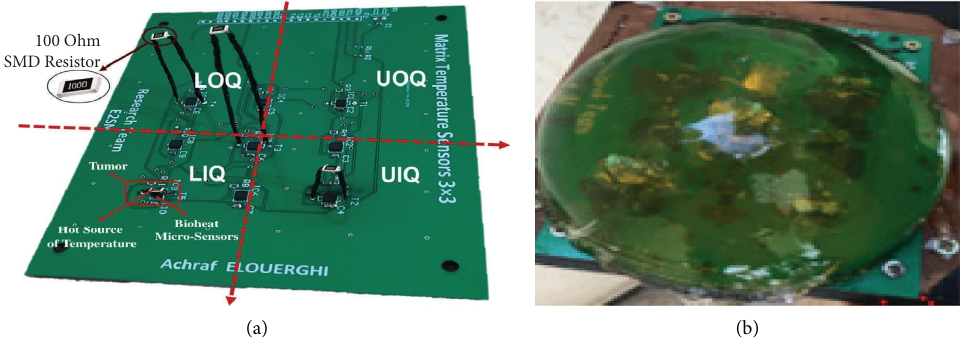
Figure 8: Support realized (a) FR4 PCB board with hot source of temperature and bioheat microsensors and (b) Combination of board and phantom.